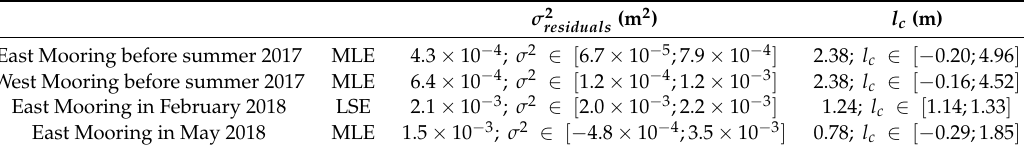
and l c and their 95% confidence residuals